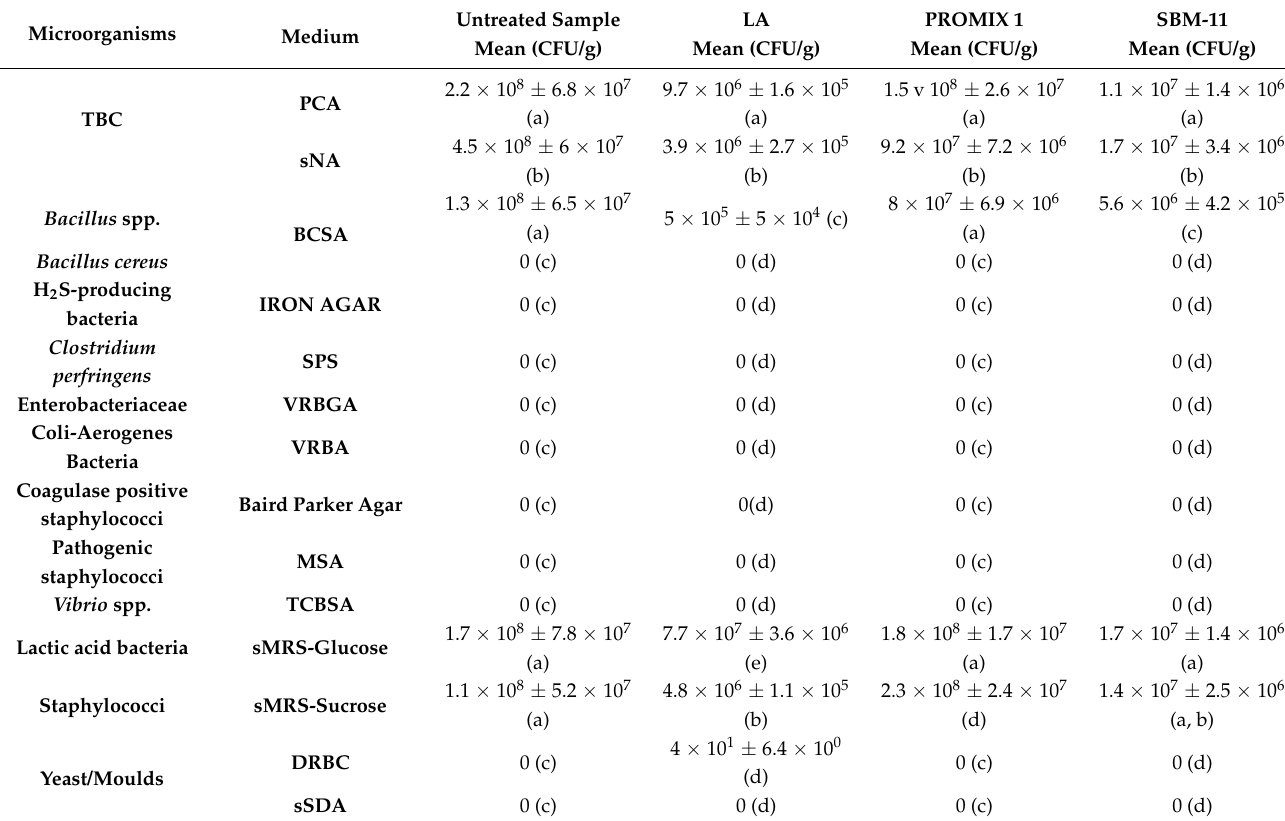
TBC: total bacterial count at 30 ◦ C; CFU: Colony Forming Unit; PCA: plate count agar; sNA: saline Nutrient Agar; BCSA: Bacillus chromoselect agar; TCBSA: Thiosulphate citrate bile sucrose agar; SPS: Sulphite polymyxin sulphadiazine agar; sSDA: saline Sabouraud Dextrose